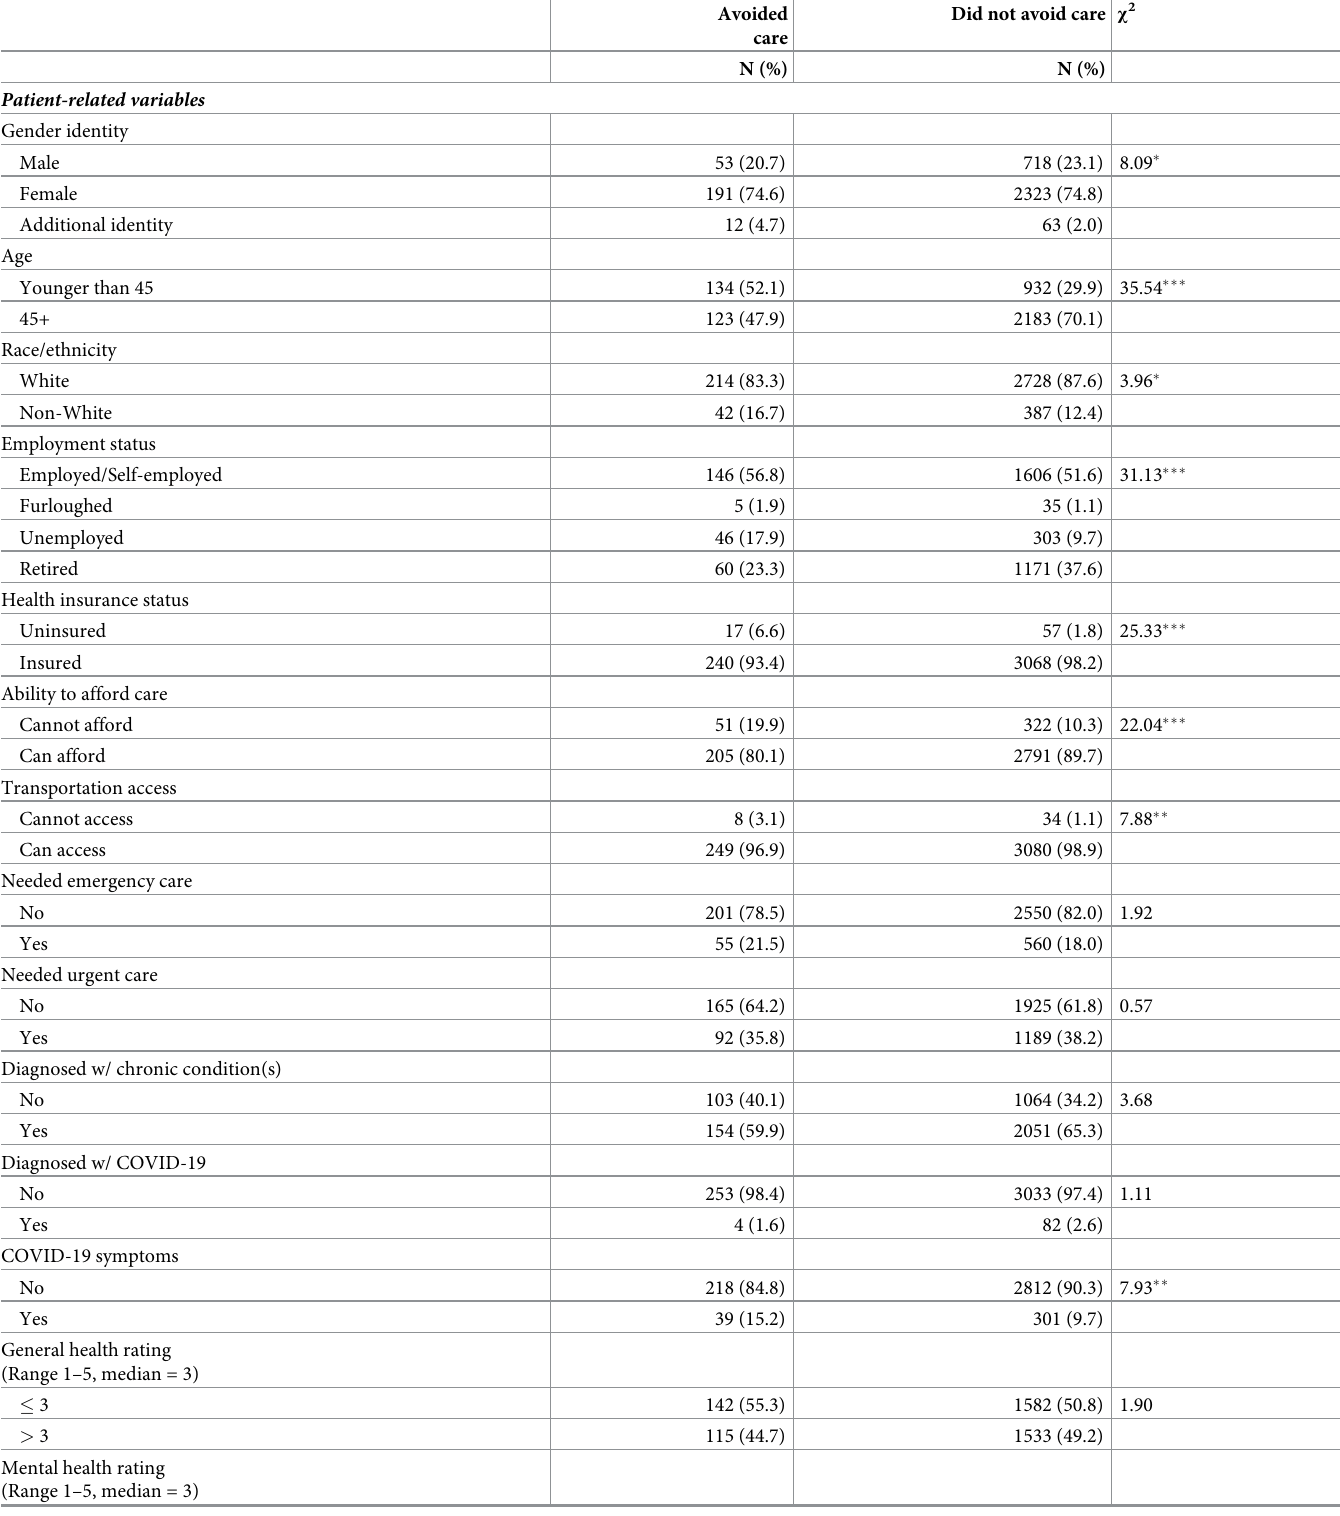
Table 2. Chi-square examining independent variables associated with care avoidance (n =